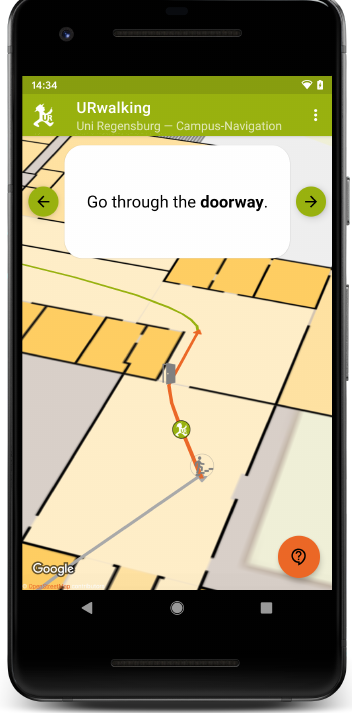
Figure 6. User interface of the app during